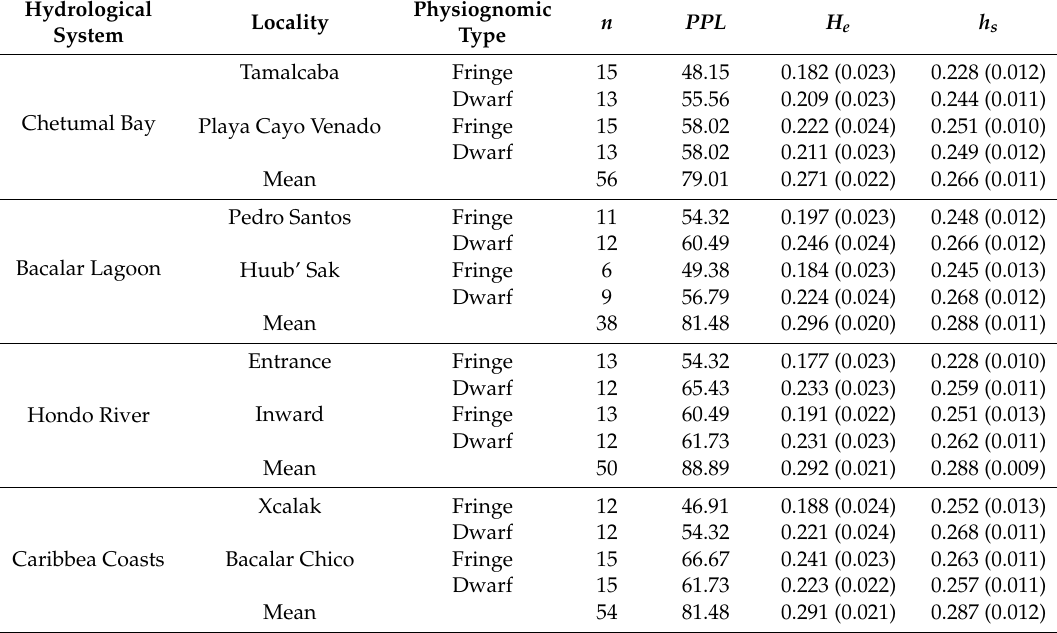
Table 1. Genetic diversity parameters estimated with G en A lex for Rhizophora mangle from four di ff erent hydrological systems and for each physiognomic type inside all localities in southern Quintana Roo, Mexico. Number of samples ( n ), percentage of polymorphic loci ( PPL (%)), expected heterozygosity with a standard error ( H e ± SE), and estimated genetic diversity determined by H ickory v1.1 ( h s ± SD).